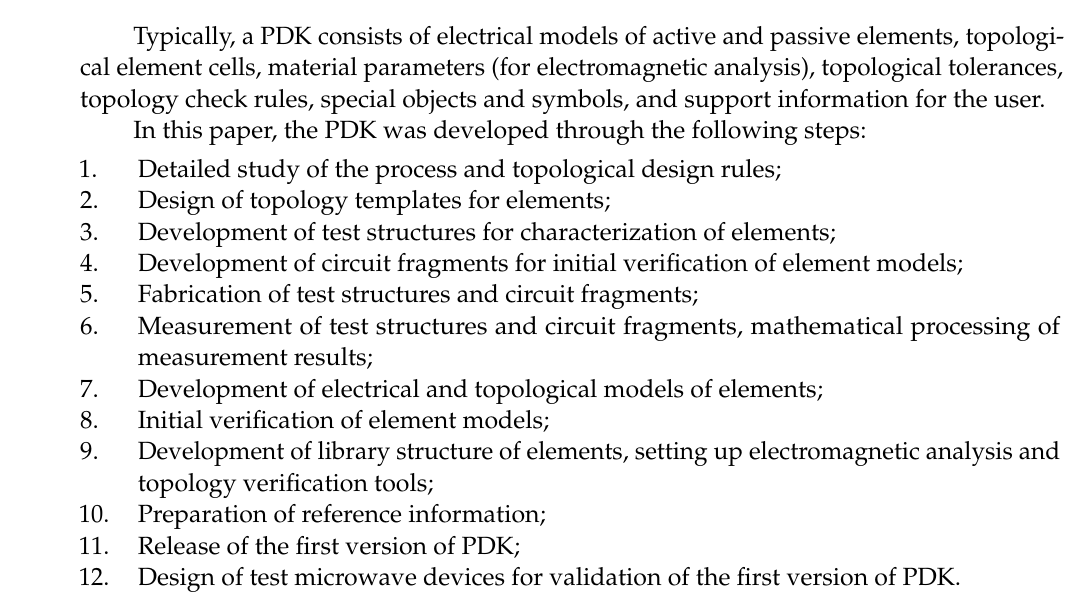
Figure 2. MMIC topology